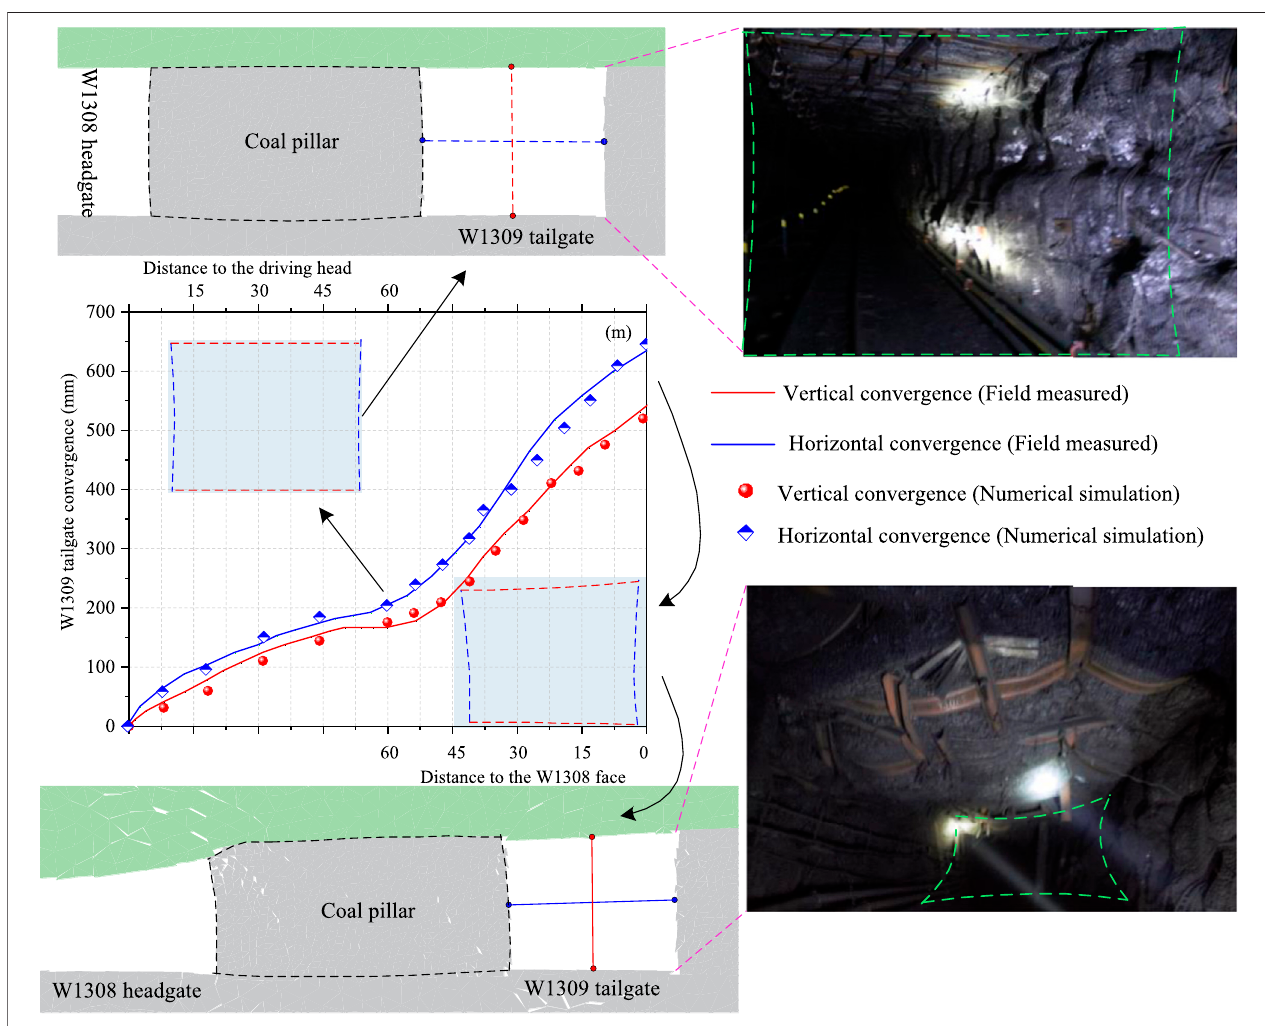
FIGURE8| Thesimulationandon-siteresultsofW1309tailgatedeformationduringthedrivingofW1309tailgateandW1308headgate,aswellasW1308working face mining.